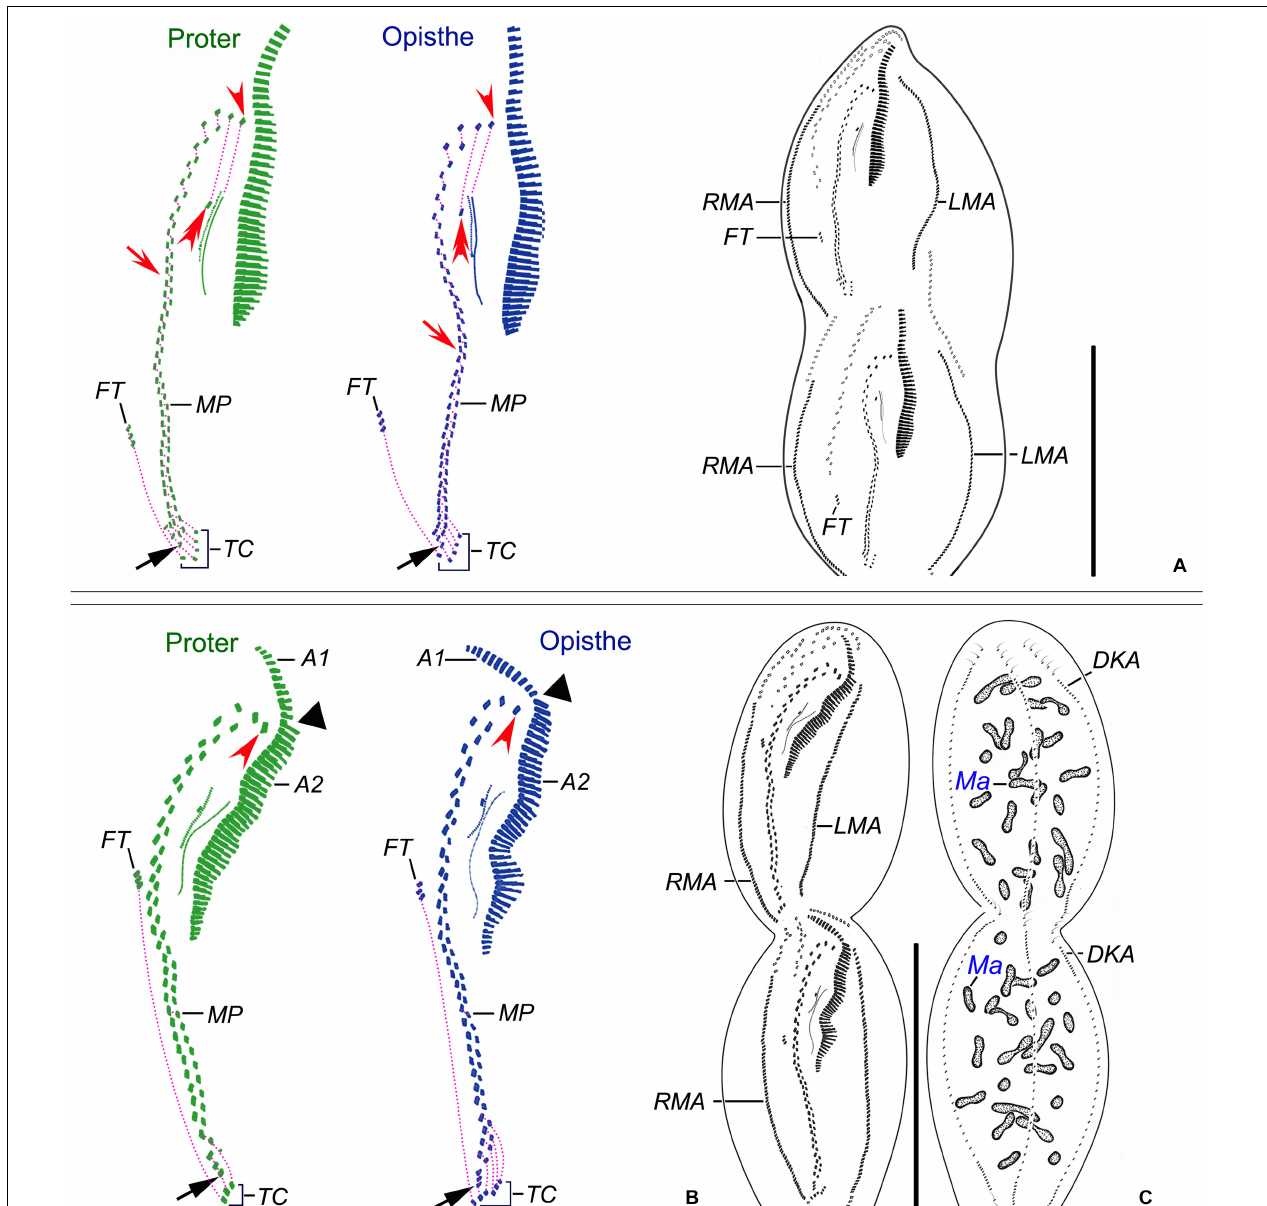
FIGURE 5 | Nothoholosticha luporinii n. sp., a late (A) and a very late (B,C) divider after protargol impregnation. Magnified details of the proter’s ciliature are in green colour, while those of the opisthe’s ciliature are in blue colour. Frontal-ventral-transverse cirri originating from the same anlagen are connected by dotted lines. (A) Ventral view of a late divider, showing the buccal cirri (red double-arrowheads), the leftmost frontal cirri (red arrowheads), the single pretransverse cirri (black arrows), and the migrating frontoterminal cirri. (B,C) Ventral (B) and dorsal (C) views of a very late divider, showing the formation of a gap in the adoral zone of membranelles (black triangles) as well as the formation of the anlagen for marginal cirral rows and dorsal kineties. The leftmost frontal cirri are marked by red arrowheads, the pretransverse cirri by black arrows. A1 and A2, crown and lapel adoral membranelles; DKA, dorsal kinety anlagen; FT, frontoterminal cirri; LMA, left marginal cirral row anlagen; Ma, macronuclear nodules; MP, midventral cirral pairs; RMA, right marginal cirral row anlagen; TC, transverse cirri. Scale bars = 140 µ m.